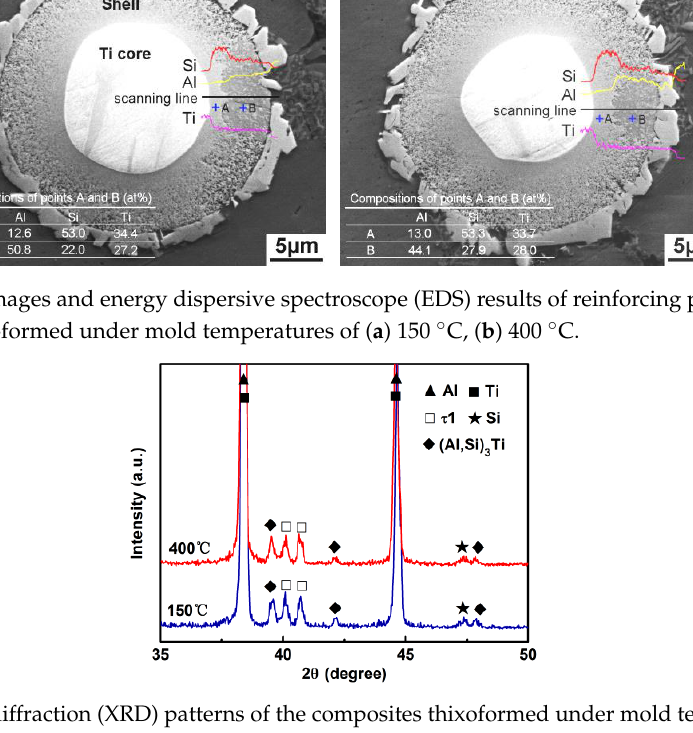
Figure 8. X-ray diffraction (XRD) patterns of the composites thixoformed under mold temperatures of 150 °C and 400 °C.